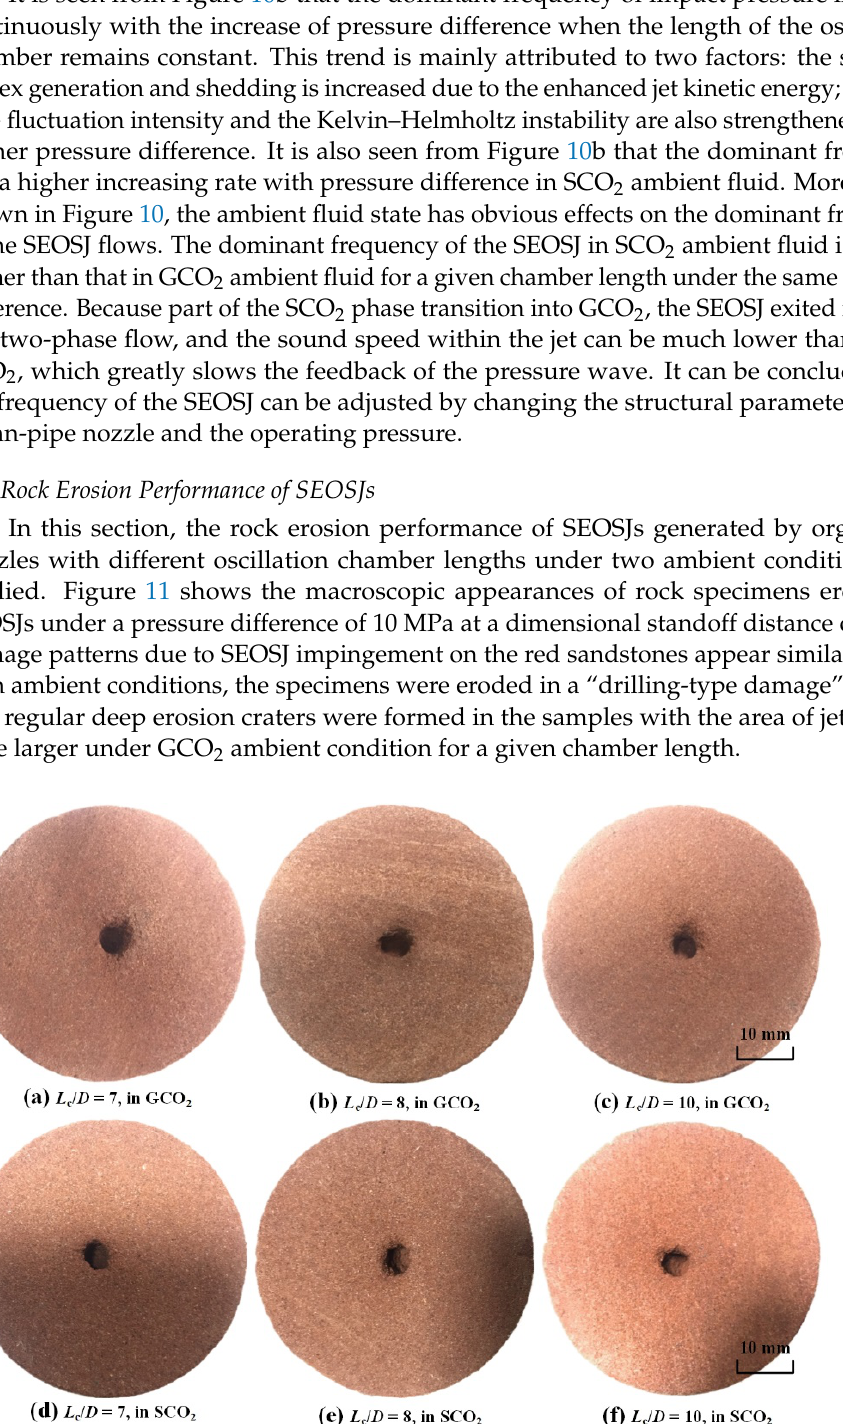
Figure 11. Macroscopic appearances of rock specimens under SEOSJ impingement: ( a ) L c / D = 7, in GCO 2 ; ( b ) L c / D = 8, in GCO 2 ; ( c ) L c / D = 10, in GCO 2 ; ( d ) L c / D = 7, in SCO 2 ; ( e ) L c / D = 8, in SCO 2 ; ( f ) ∆ P = 10 L c / D = 10, in SCO 2 . (Δ P = 10 MPa) ( f ) L c / D = 10, in SCO 2 . (